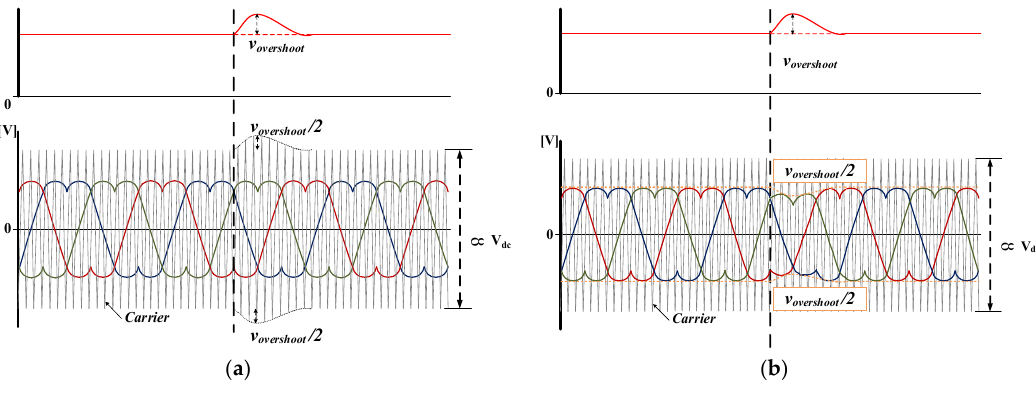
Figure 6. Two cases for the realization of the compensation value: ( a ) altered carrier wave: compensation value is applied in carrier wave; and ( b ) altered reference wave: compensation value is applied in reference wave.